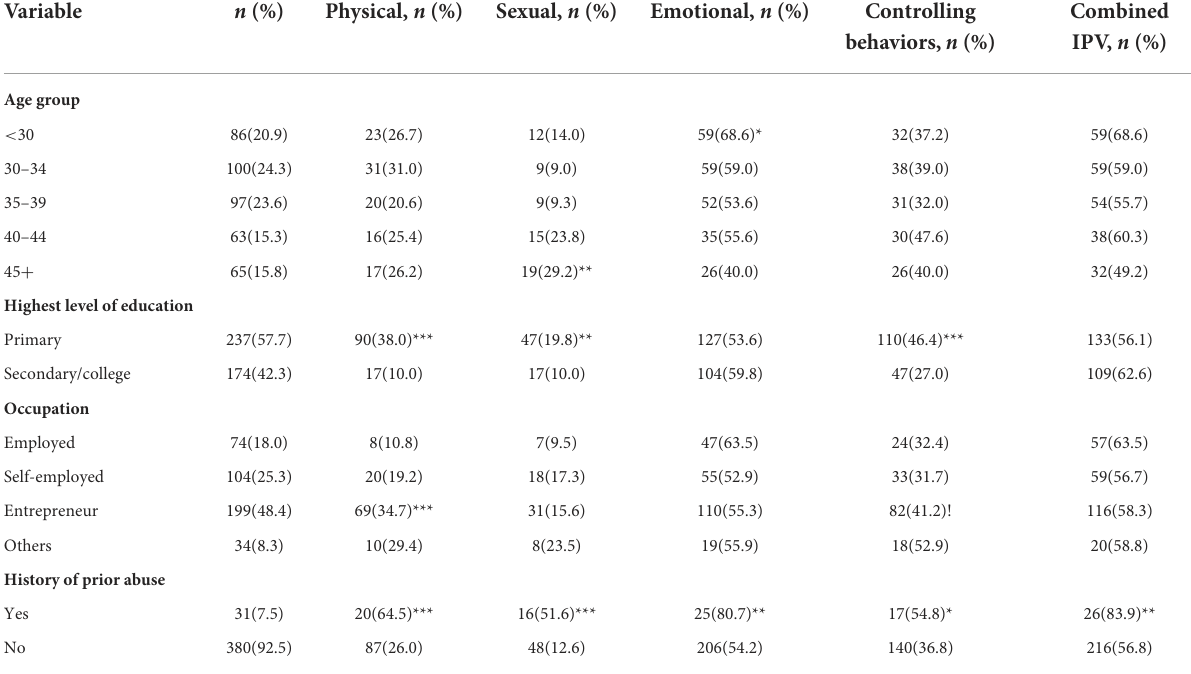
TABLE 3 Bivariate analysis showing demographic factors among women associated with intimate partner violence.